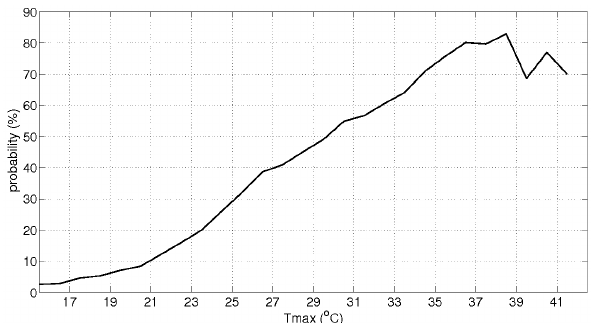
Figure 3. Probability that the daily maximum 8-h average ozone will exceed 60 ppb for a given daily maximum temperature (Tmax) for the Marousi ozone station. Values are plotted at the mid-point temperature of the 1°C temperature bin.